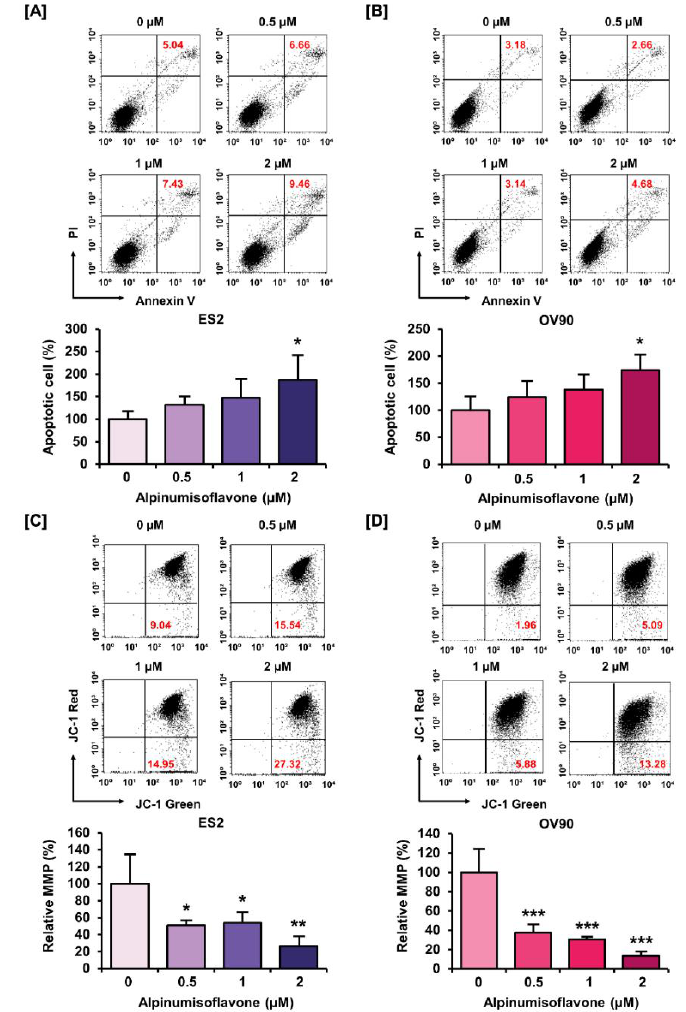
Figure 3. Alteration of mitotic membrane potential (MMP) and late apoptotic cell number by alpinumisoflavone in both cell lines. ( A , B ) The death of ES2 and OV90 cells treated with alpinumisoflavone for 48 h was determined using annexin V and PI assay. ( C , D ) The effect of alpinumisoflavone